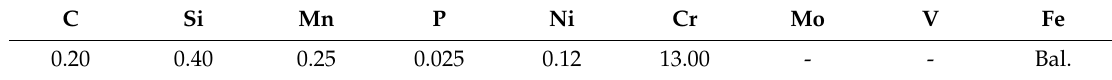
Table 1. Chemical composition of the matrix material in the present study (wt%).